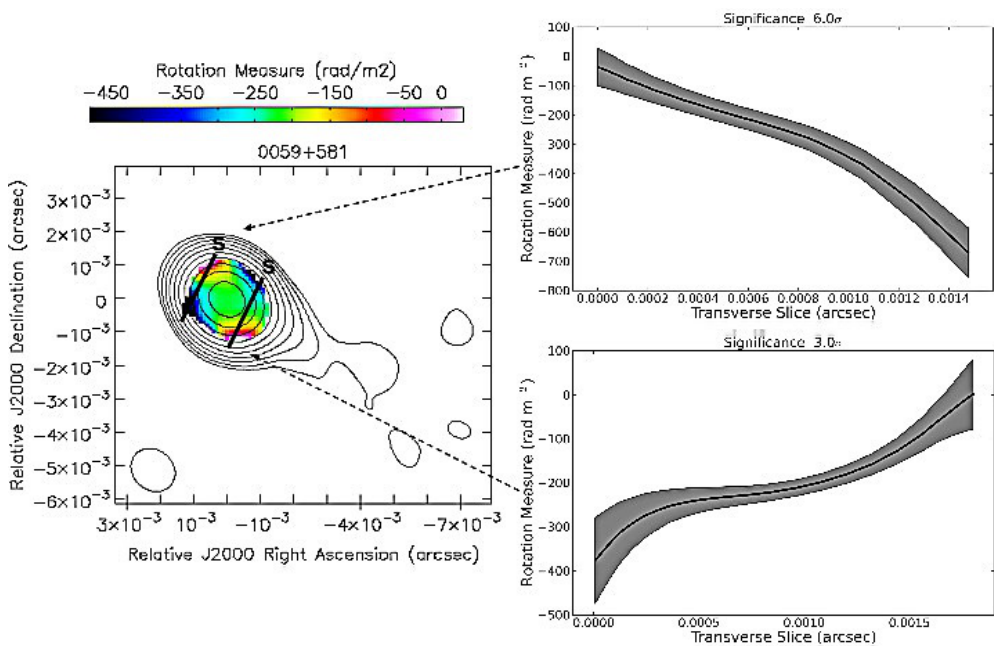
Figure 3. Transverse RM (in units of rad/m 2 ) gradient across the VLBI core region and jet of the AGN 0059+581, based on the 8.1–15.3 GHz data of [4], reanalyzed in [9]. Intensity contours with the RM distribution superposed in colour are shown. The beam size is shown in the lower left-hand corner of the map. The panels to the right show RM slices for the regions indicated in the map, with the slices starting by the letters “S” on the left-hand panel. The significances of the two slices are 6.0 σ (core region) and 3.0 σ (jet), making both of the oppositely directed transverse RM gradients statistically